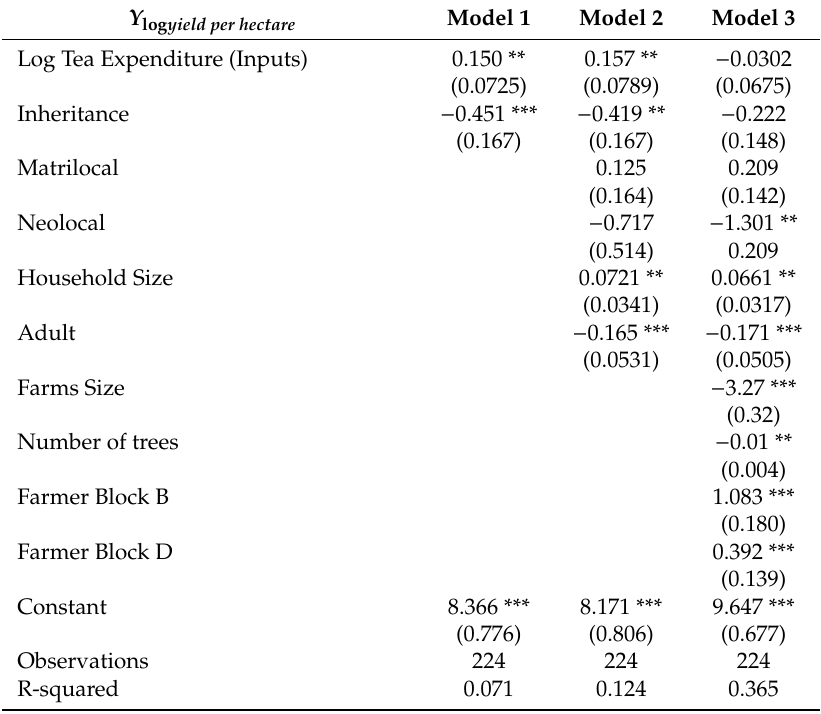
Table 5. E ff ects of specific variables on yield per hectare (OLS Equation